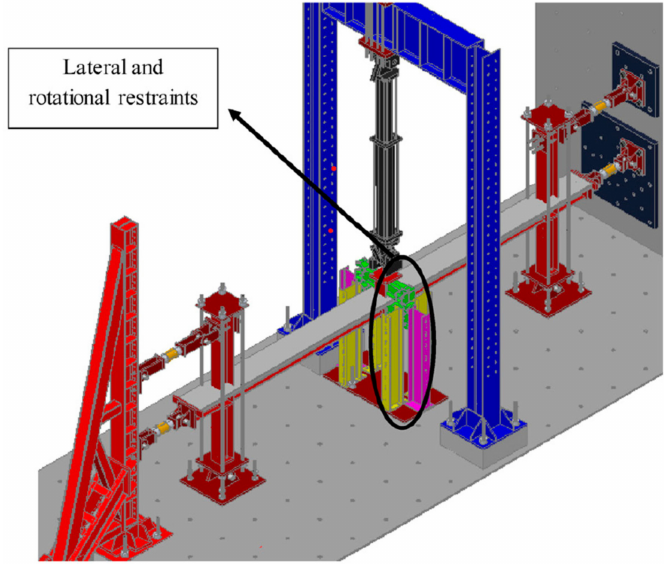
Figure 7. Test setup rigs of composite frame tests conducted by Yang et al.